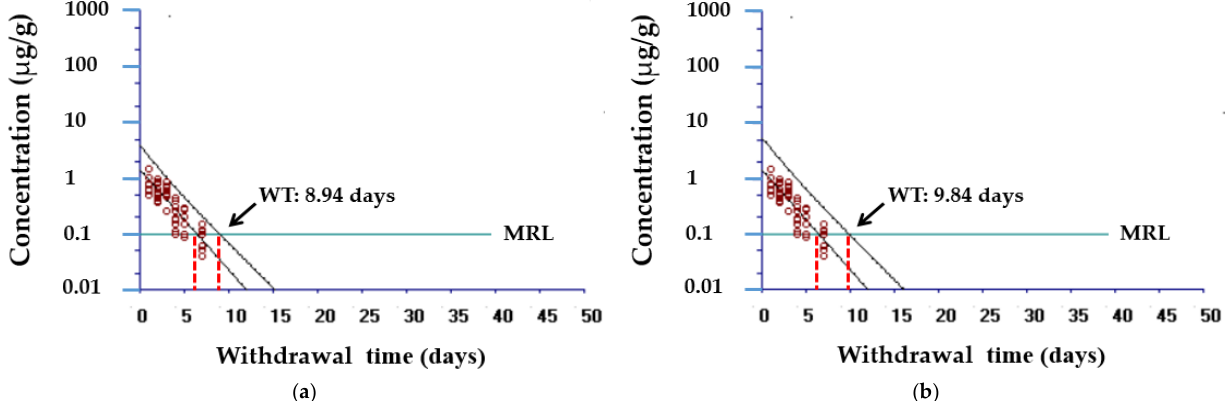
Figure 3. Residue depletion of tylosin from muscle after a single intramuscular administration of 10 mg/kg tylosin tartrate for 1 week: ( a ) 95% statistical tolerance limit with 95% confidence; ( b ) 99% statistical tolerance limit with 95% confidence. Data are expressed from 10 olive flounders at each time point. The maximum residue limit (MRL) used was an official level of 0.1 µg/g.